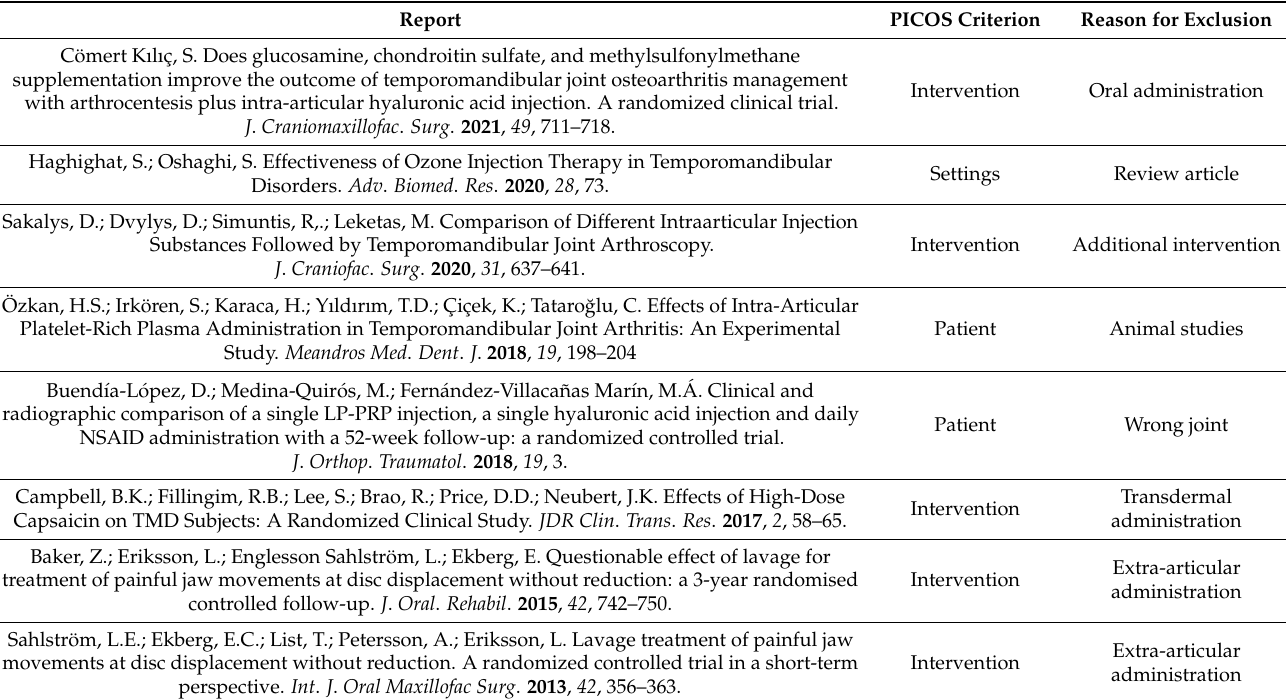
Figure 1. Studies selection process. Table 2. Records excluded at the eligibility stage.